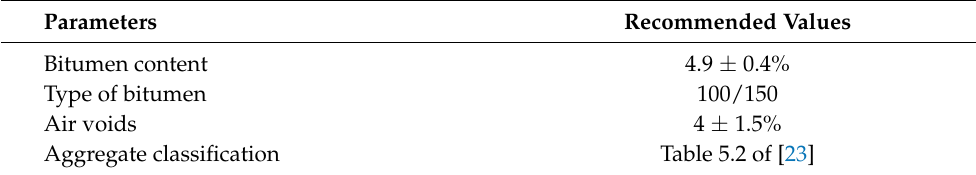
Table 2. Principal parameters of some aggregates or elements of the road pavement.